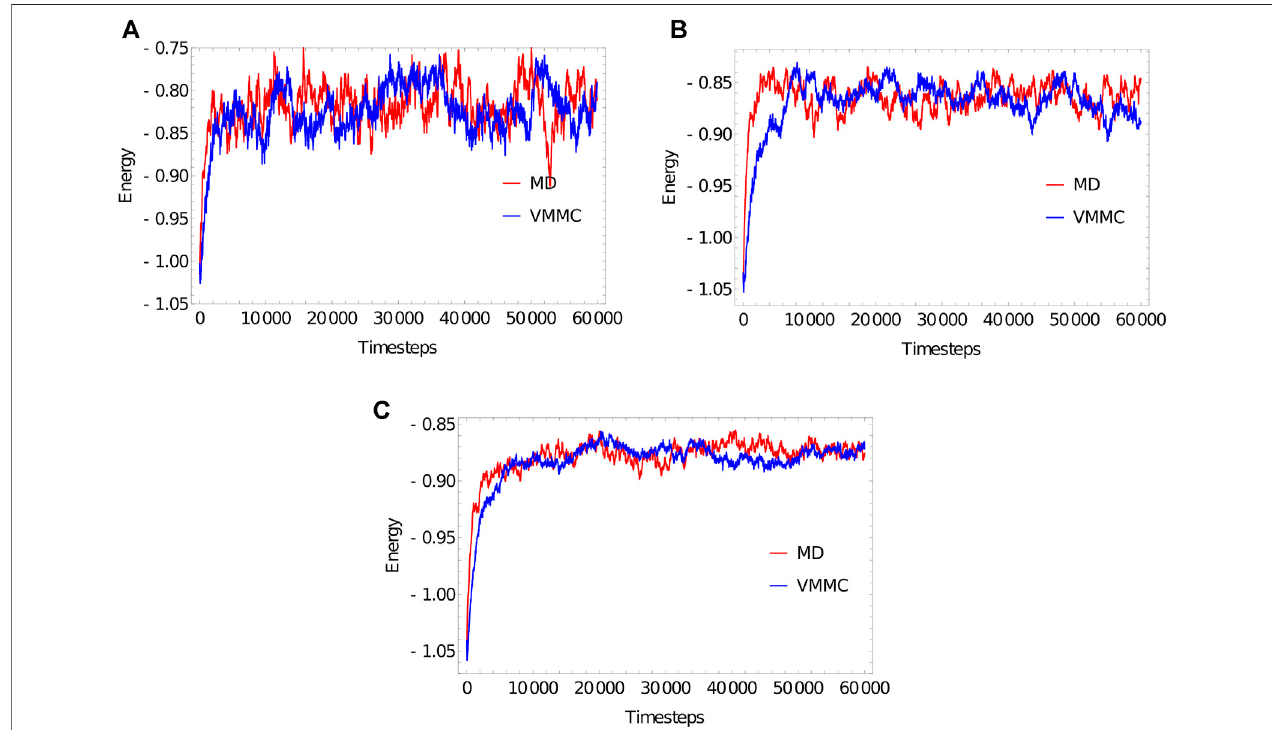
FIGURE 3 | Equilibration plots for the ploy (dT) molecules with (A) 20 bases, (B) 100 bases, (C) 1,000 bases, obtained as averages over 20 independent simulations. For both MD and VMMC, the potential V 0 is plotted as a function of simulation progress, in units of reduced time (3.03 ps) for MD and attempted steps per particle for VMMC.